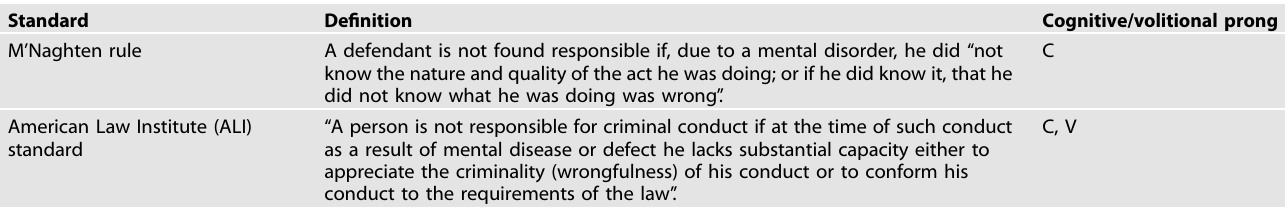
Table 1. Insanity defense